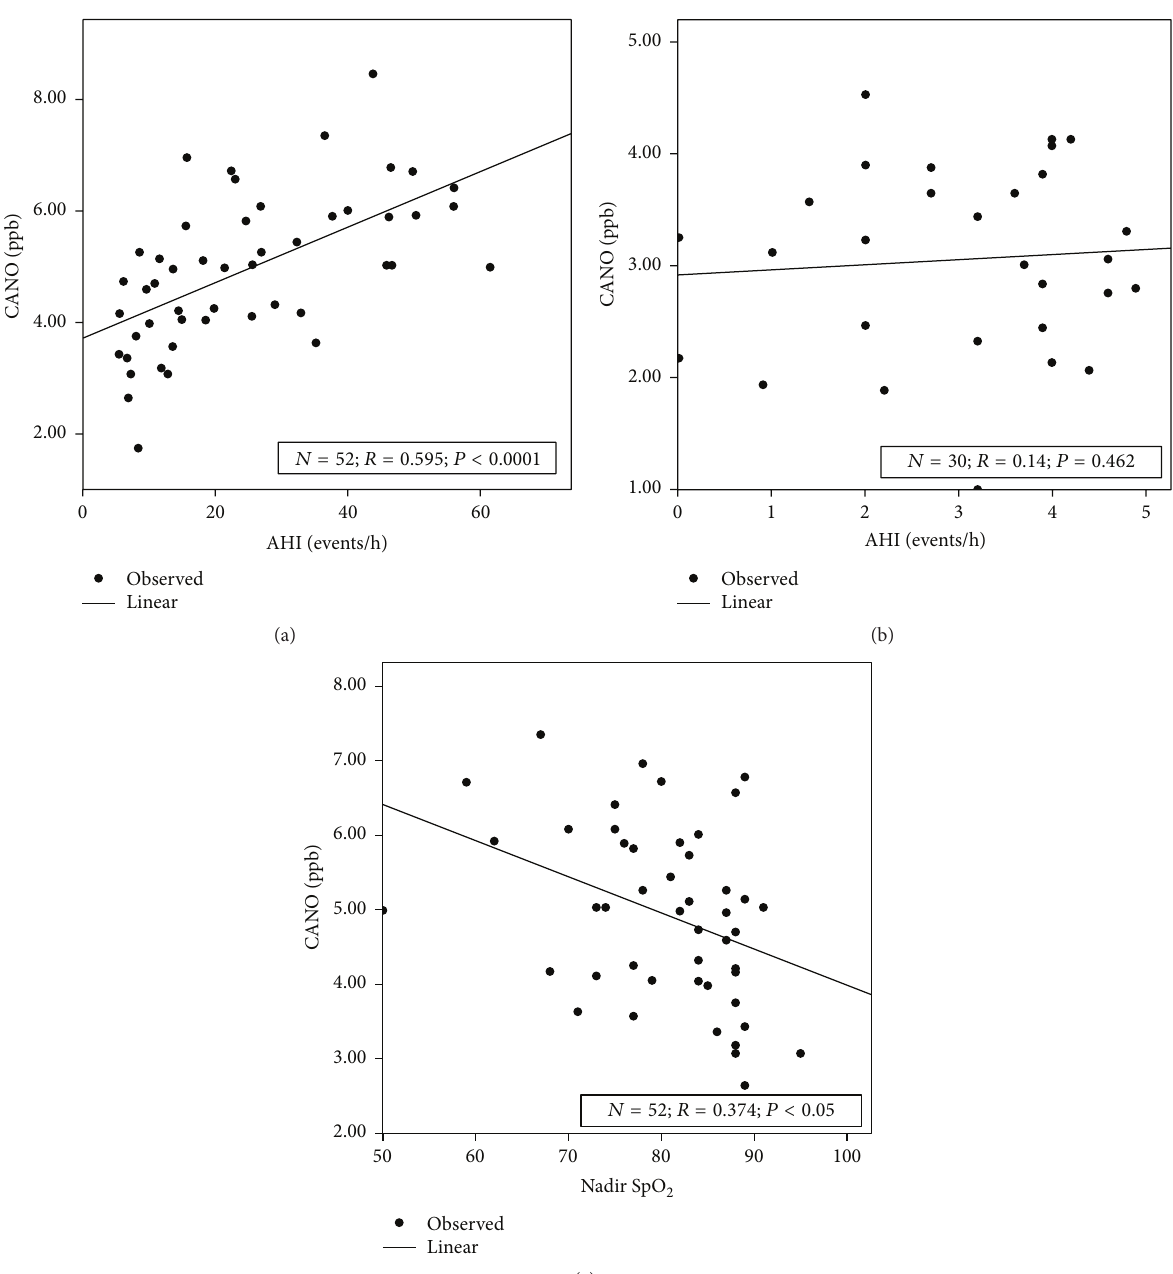
Figure 2: (a) Correlation between post-PSG CANO and AHI in subjects with OSA. There was a significant correlation between CANO and AHI ( 𝑅 = 0.595 , 𝑃 < 0.0001 ). CANO: alveolar concentration of nitric oxide; AHI: apnea-hypopnea index. (b) Correlation between post-PSG CANO and AHI in control subjects. There was no significant correlation between CANO and AHI ( 𝑅 = 0.073 , 𝑃 = 0.706 ). CANO: alveolar concentration of nitric oxide; AHI: apnea-hypopnea index. (c) Correlation between post-PSG CANO and nadir SpO 2 in subjects with OSA. There was a significant correlation between CANO and nadir SpO 2 ( 𝑅 = −0.374 , 𝑃 = 0.034 ). CANO: alveolar concentration of nitric